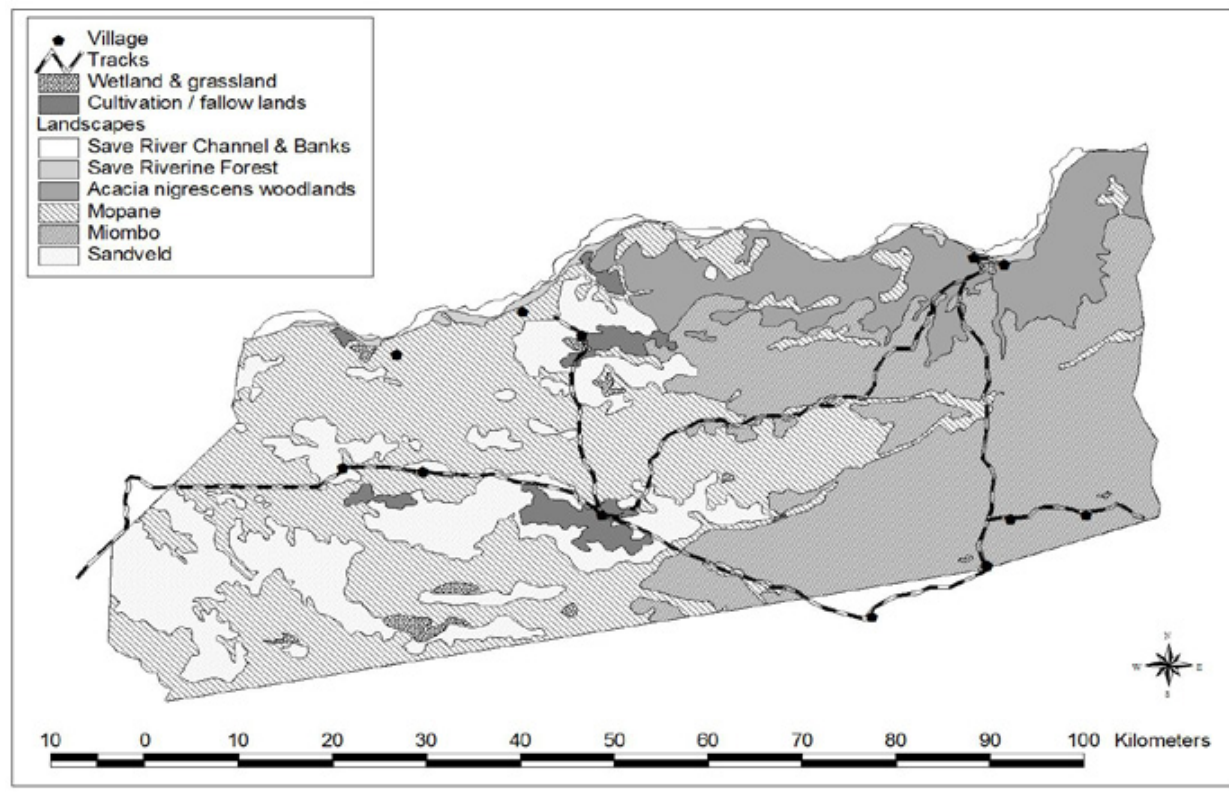
FIGURE 6 Landscape map of the Parque Nacional de